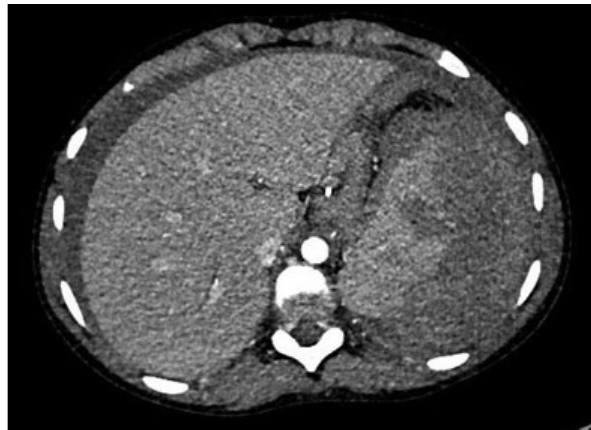
Fig. 1 Axial image from the contrast-enhanced computed tomog- raphy scan performed on admission, showing rupture of the lateral margin of the spleen and a large perisplenic hematoma. Free fl uid is also seen lateral to the liver.